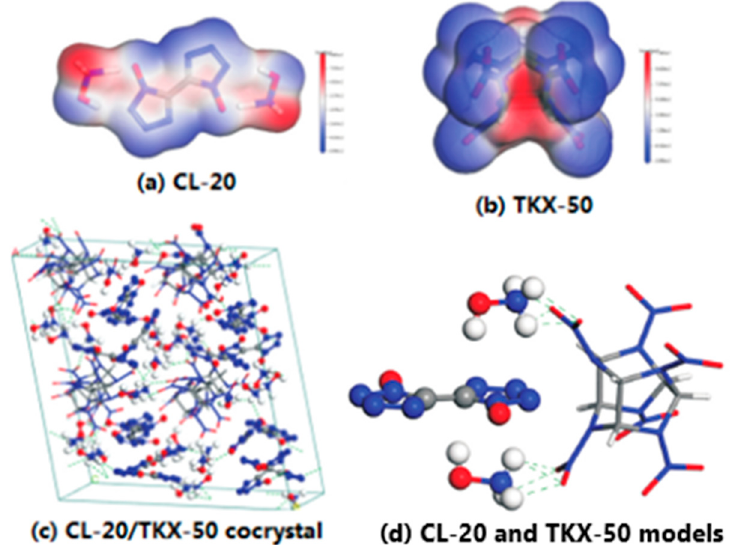
Figure 3. Surface electrostatic potential energy distribution map of CL-20 ( a ) and TKX-50 ( b ), and the equilibrium structure of CL-20/TKX-50 cocrystal model ( c ), CL-20 and TKX-50 models ( d ) [34], with permission from Huo Zha Yao Xue Bao, 2020.